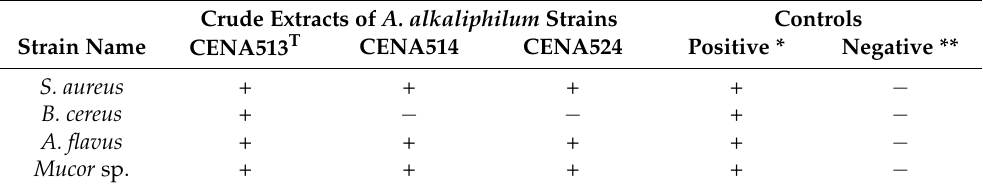
Table 2. Bioactivity screening results for Aliinostoc alkalphilum strains.